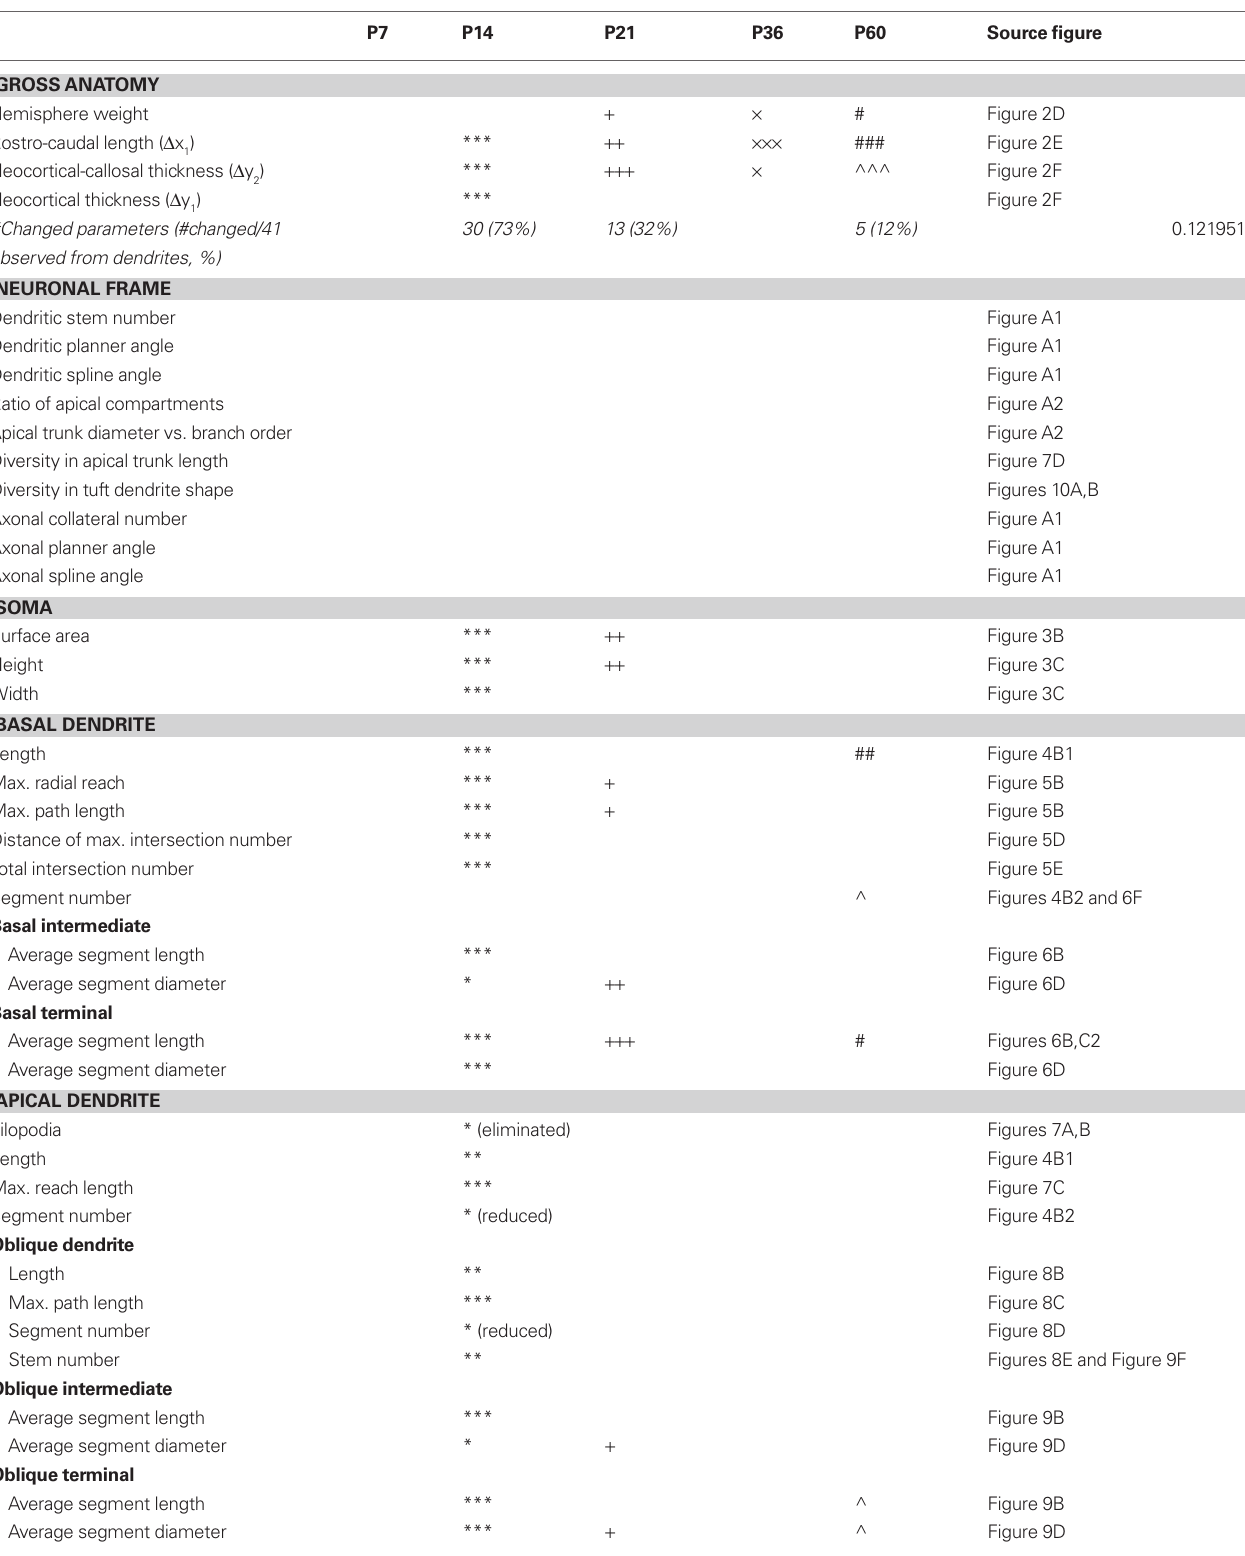
Table A1 | Statistical results from quantitative morphological analyses of hemisphere and TTL5 cellular